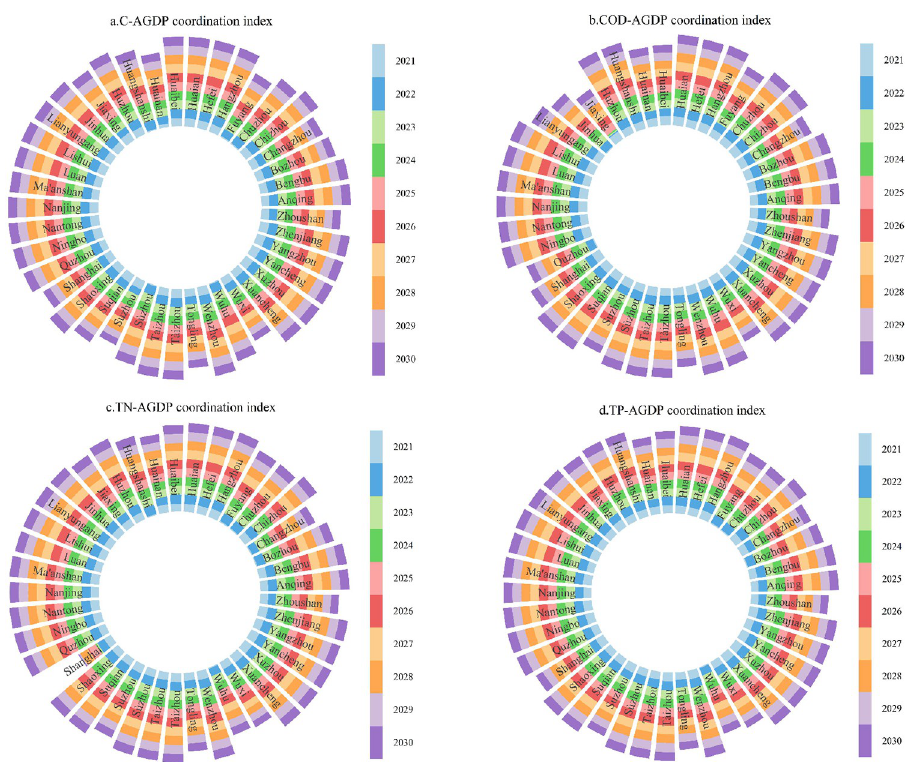
Fig 4. Predicted decoupling of agricultural pollution and carbon reduction from agricultural economic